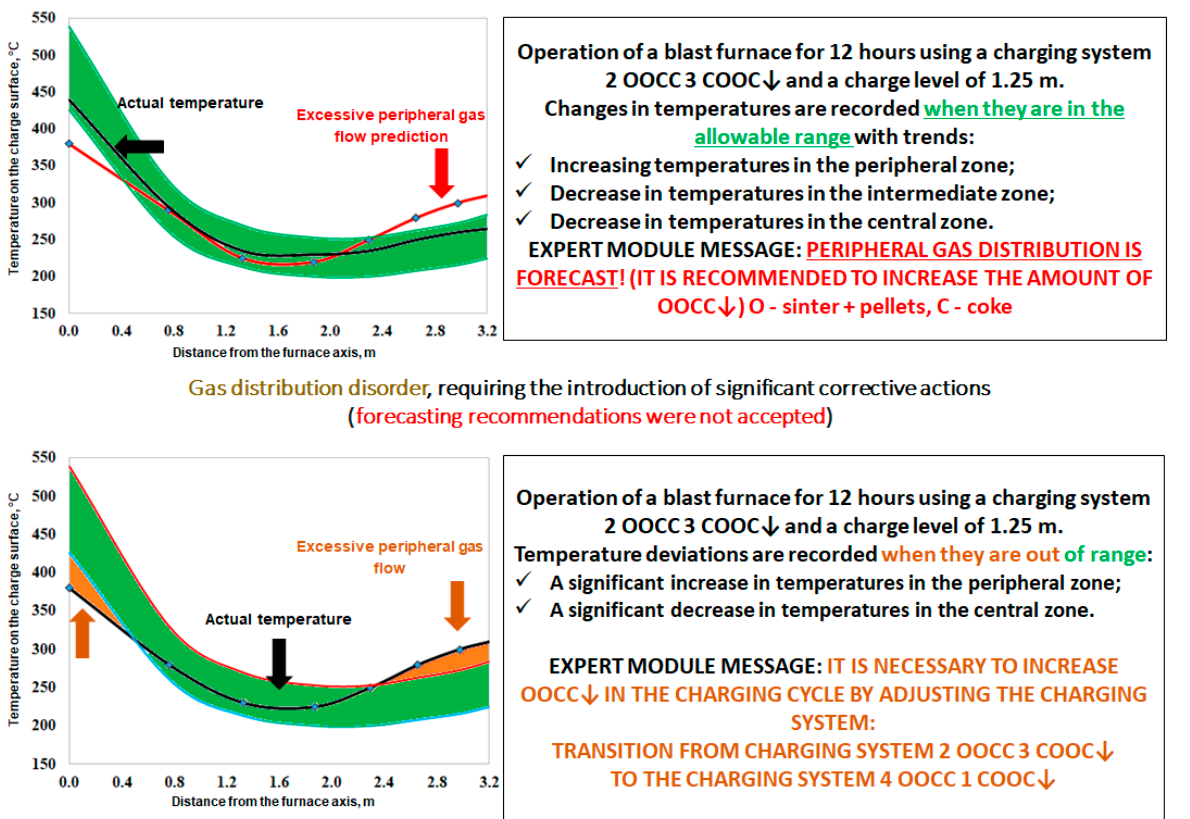
Figure 5. Examples of DSS (expert module) operation in interactive